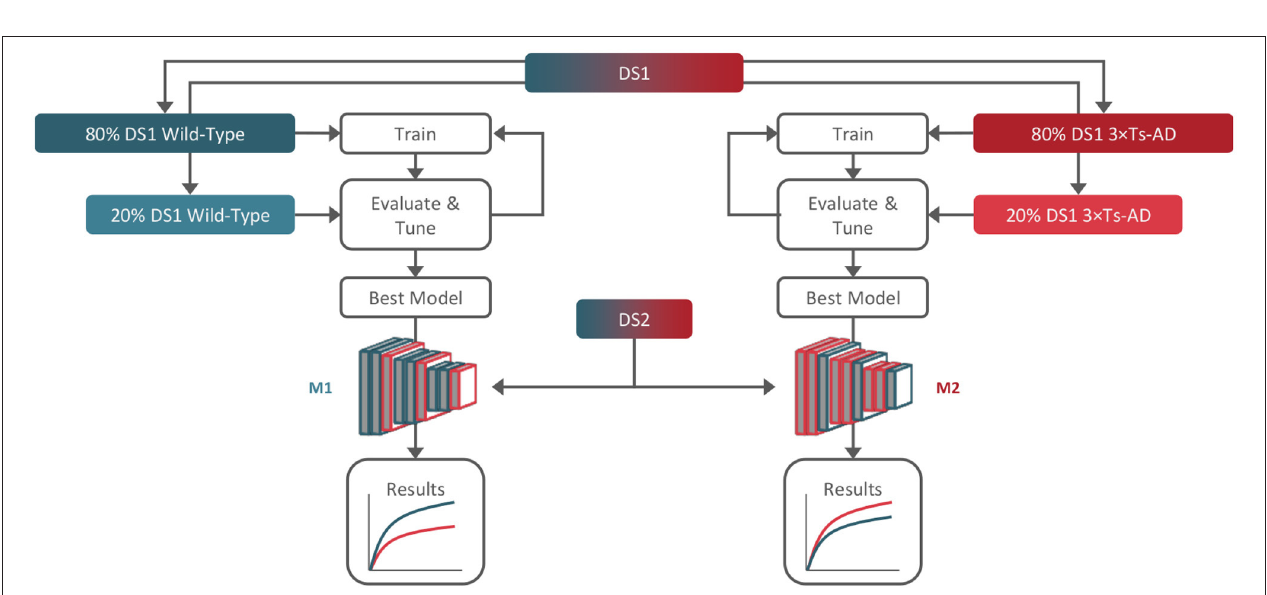
FIGURE 2 | Training, tuning, and testing workflow. Dataset 1 (DS1) was used for training and tuning (80/20%) of two models, M1 and M2, using only wild-type and 3 × Tg-AD B-scans, respectively. Dataset 2 (DS2) containing both genotypes was used for hold-out testing with both models.